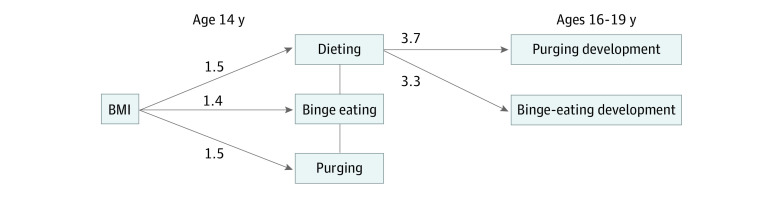
Significant Associations Between Body Mass Index (BMI), Disordered Eating Behaviors (DEBs) at 14 Years, and the Development of Future DEBs at 16 or 19 YearsAll models account for both sex and study site. For each DEB shown in the middle column, other DEBs have been accounted for in the model (eg, in the association between dieting and purging development, binge eating at baseline was controlled for). The arrows indicate a statistically significant association with the false discovery rate correction (corrected P < .05 for 15 tests); numbers next to arrows, odds ratios.